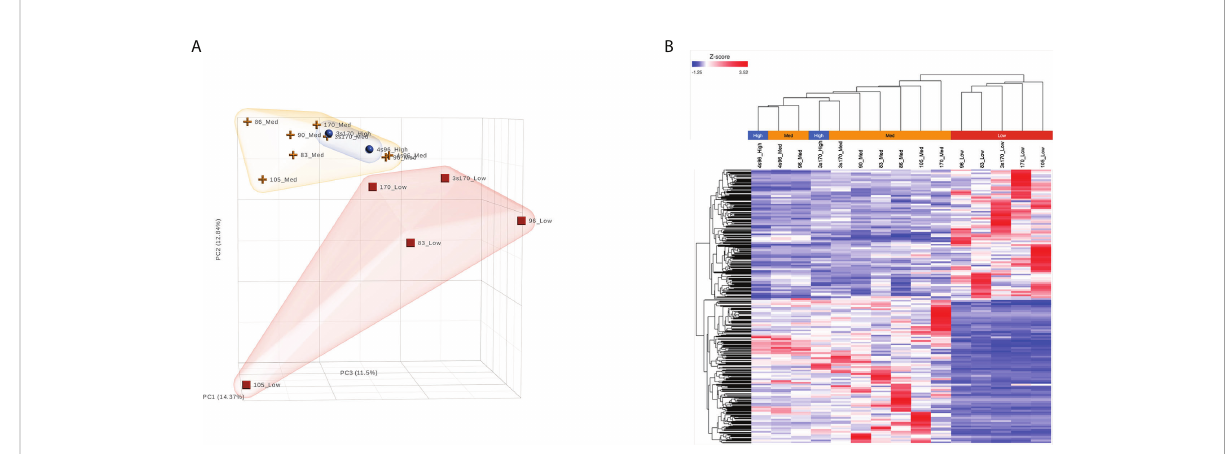
FIGURE 3 B-ALL LICs can be distinguished based on glucose uptake and molecular pro fi le. RNA-Seq analysis was performed on fi ve different human B- ALL PDX models fl ow sorted into subpopulations based on glucose uptake and NBDG fl uorescence intensity: NBDG-low (Low), NBDG-med (Medium), and NBDG-high (High). Raw sequence data (FASTQ) were processed for read alignment, gene-level quanti fi cation, normalization, and differential expression as described in Materials and Methods. (A) Principal component analysis (PCA) performed on normalized read counts demonstrated organization of the samples into distinct groups of NBDG-low and a group comprised of NBDG-med and NBDG-high samples, as illustrated in the 3D PCA plot. (B) Differential expression analysis (DESeq2) identi fi ed a combined total of 2,512 DETs (p<0.05) in group comparison of NBDG-low samples to NBDG-med and NBDG-high samples. Hierarchical clustering and heat map visualization of the DETs (NBDG-low vs. NBDG-med, NBDG-low vs. NBDG-high, p<0.05) is presented and demonstrated distinct clustering of the NBDG-low samples and grouping of the NBDG-med and NBDG-high